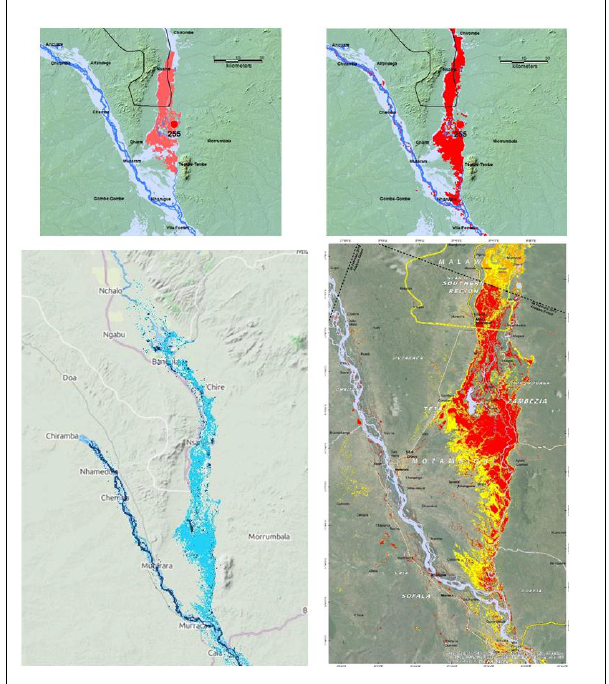
Figure 1. Malawi 2015 flood extent maps, courtesy of CIMA Foundation and UNOSAT.